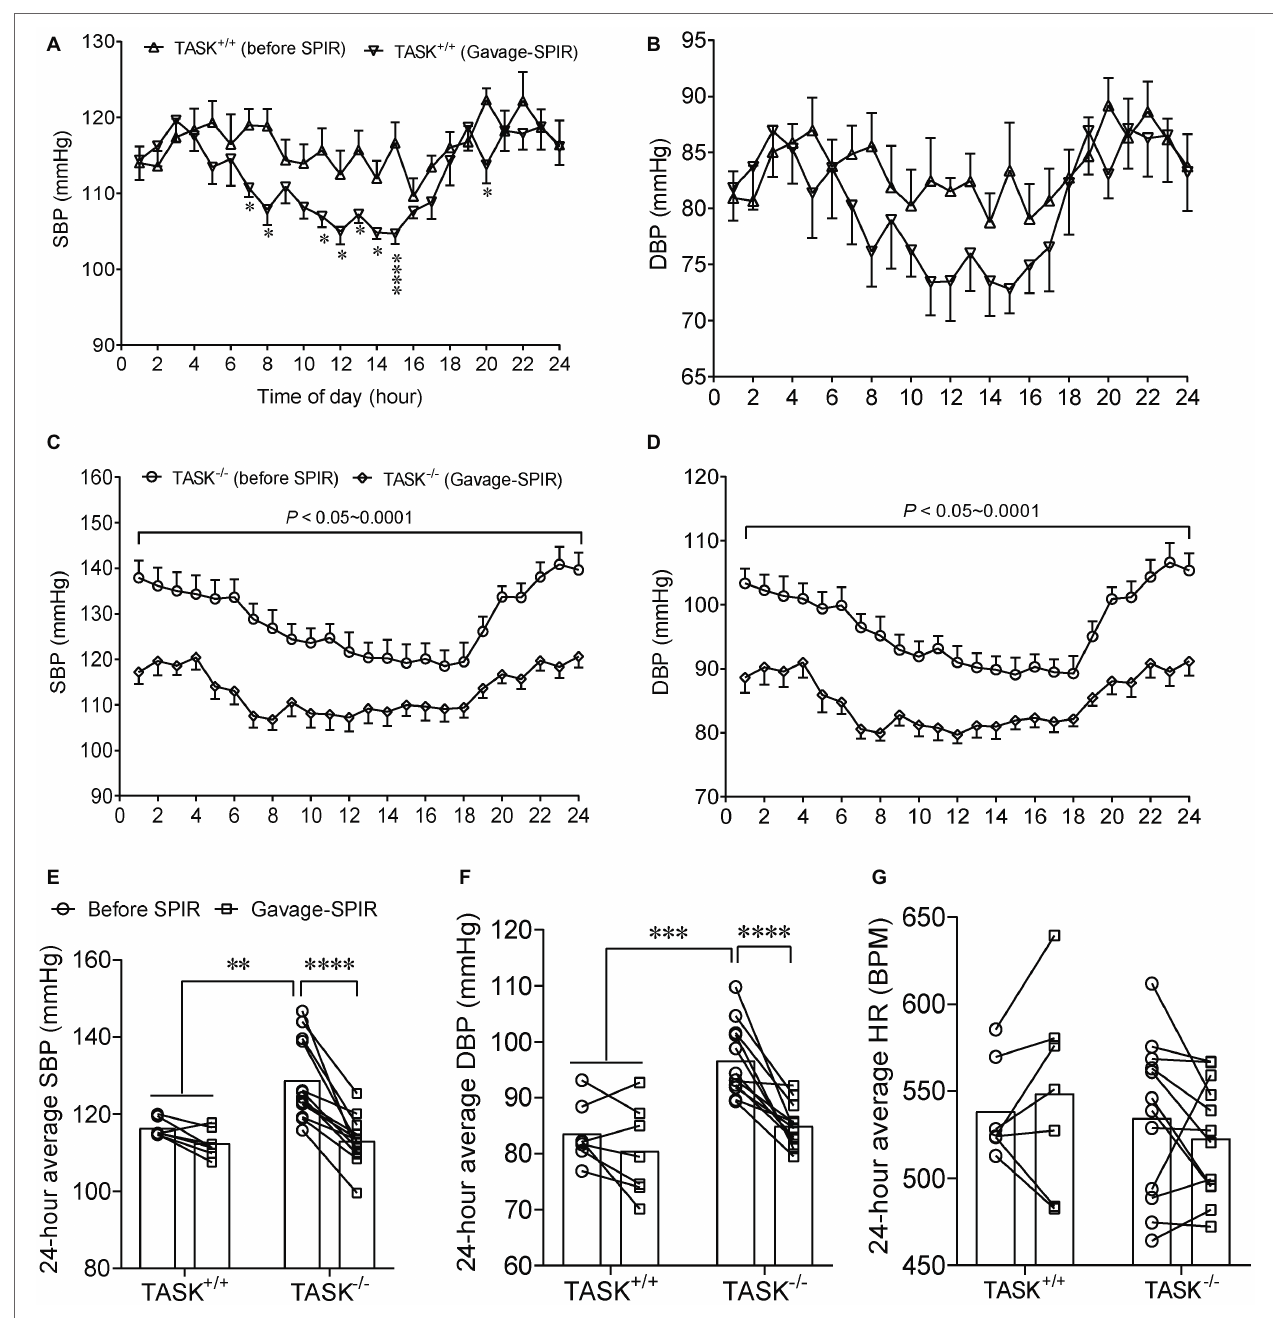
FIGURE 3 | Effect of oral administration of SPIR on arterial pressure. The MR antagonist SPIR was administered via oral gavage once daily for 7 days in TASK +/+ ( n = 7) and TASK − / − mice ( n = 12). (A,B) Administration of SPIR produced mild decrease in SBP only at specific time points and no obvious decrease in DBP in TASK +/+ mice. * p < 0.05, **** p < 0.0001 as indicated by two-way ANOVA with Fisher’s LSD post hoc test. (C,D) After treatment with SPIR, SBP and DBP were significantly lowered at each time point over 24 h in TASK − / − mice. (E–G) Application of SPIR markedly lowered 24-h average SBP and DBP in TASK − / − mice, with insignificant changes in TASK +/+ mice. No significant difference was observed in HR between two genotypes after MR blockade. ** p < 0.01, *** p < 0.001, **** p < 0.0001 as indicated by two-way ANOVA with Bonferroni’s multiple comparisons test. MR, mineralocorticoid receptors; SPIR,